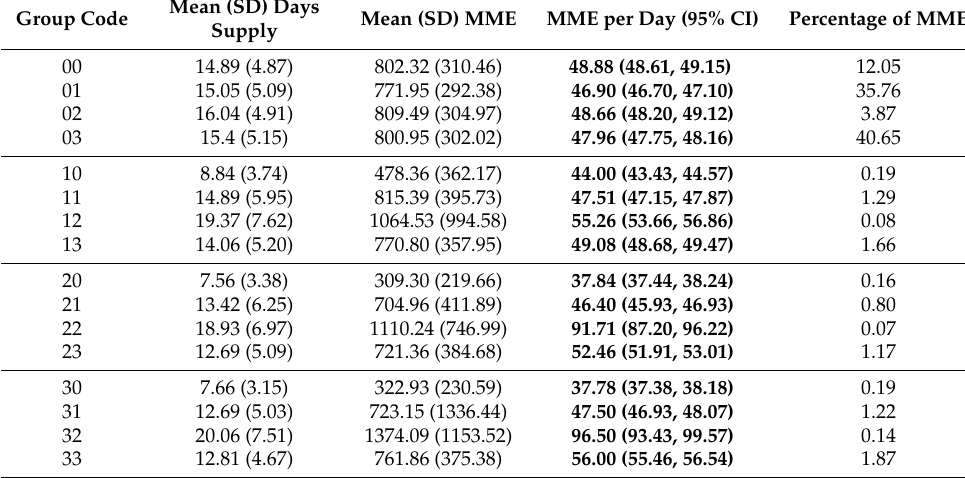
Table 2. Overview of key statistics in different coding system classes (opioid drugs only)